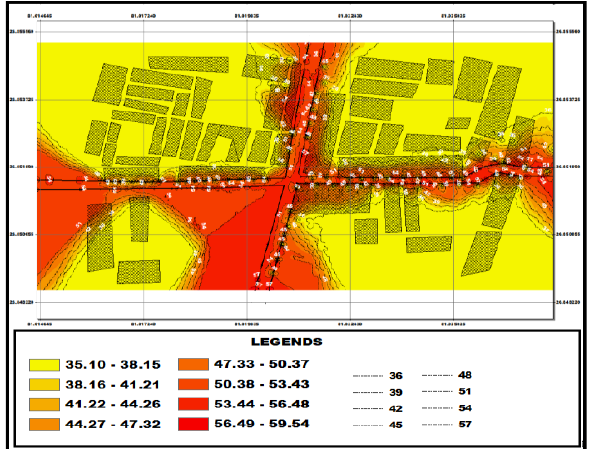
Figure 6. Noise level map of Haniman at morning time using NoiseCapture app scaled with standard SPL.